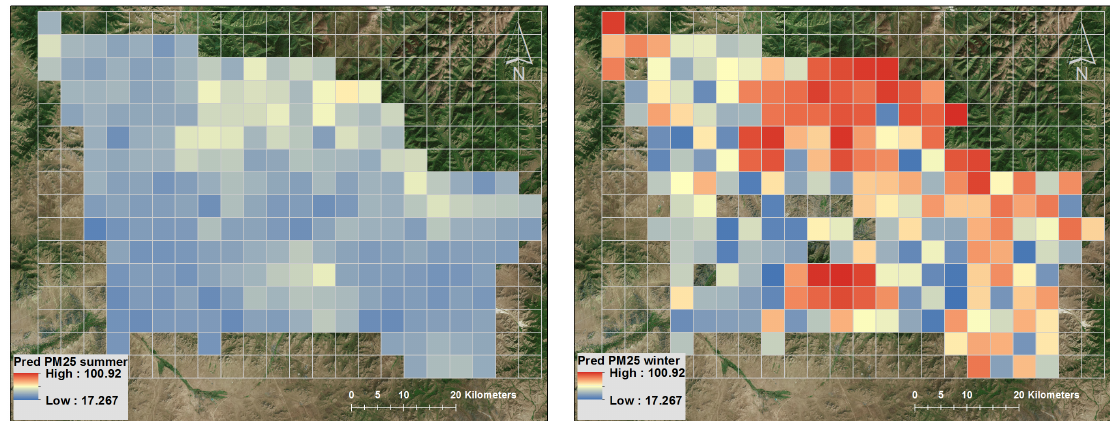
Figure 6. Predicted PM 2.5 from Support Vector Machine regression over the greater UB region averaged over study period 2011–2016 for boreal summer ( left ) and winter ( right